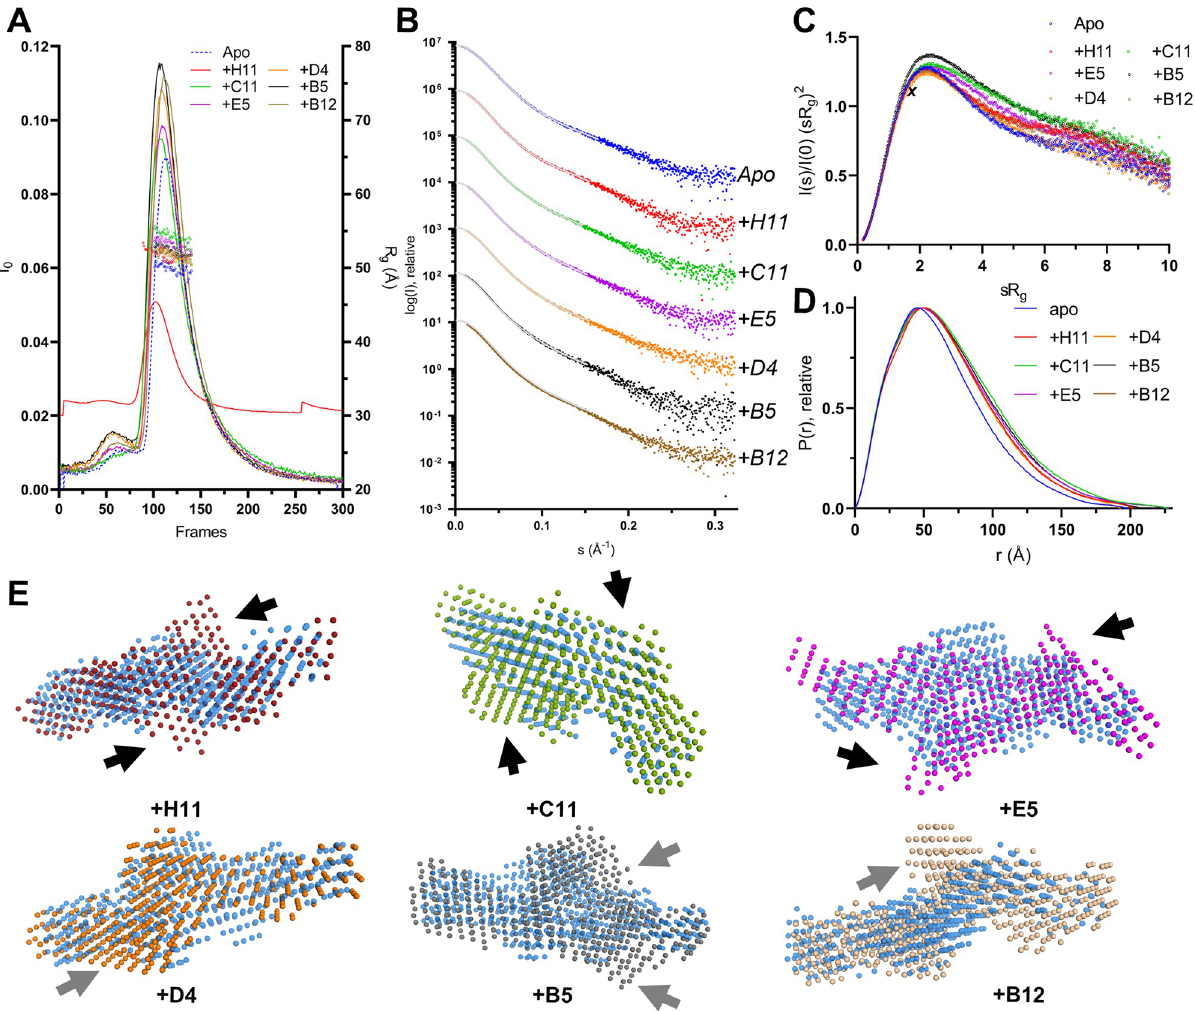
Fig 5. SEC-SAXS analysis of FLrArc-7A Nb complexes. A SEC-SAXS profiles of the complexes and unbound (Apo) FLrArc-7A. The estimated R g of the frames used for processing is shown in open circles. All complexes were measured in 20 mM HEPES, 150 mM NaCl, 0.5 mM TCEP, pH 7.5. rArc +H11 was measured on a separate occasion in 20 mM Tris, 150 mM NaCl, pH 7.4, which caused differences in intensity and the elution volume of the main peak. B Scattering curves of rArc and rArc-Nb complexes, offset for easier visualisation. Data fits from GNOM are shown as grey lines. C ffiffiffi p Dimensionless Kratky plot. The maximum of an ideal rigid spherical particle ( 3 , 1.104) is marked by X . D Distance distribution profiles. E Ab initio models of Nb-bound FLrArc-7A in various orientations, aligned with the model of the unbound protein (in transparent blue). Arrows indicate additional volumes in the complex models, which might correspond to bound Nb. Black arrows indicate two-fold symmetric binding, and grey arrows indicate additional volumes following no specific symmetry. Models were produced in DAMMIN with no forced symmetry, with χ 2 values of 0.992 (apo), 1.063 (+H11), 1.090 (+C11), 1.106 (+E5), 1.287 (+D4), 1.090 (+B5) and 1.090